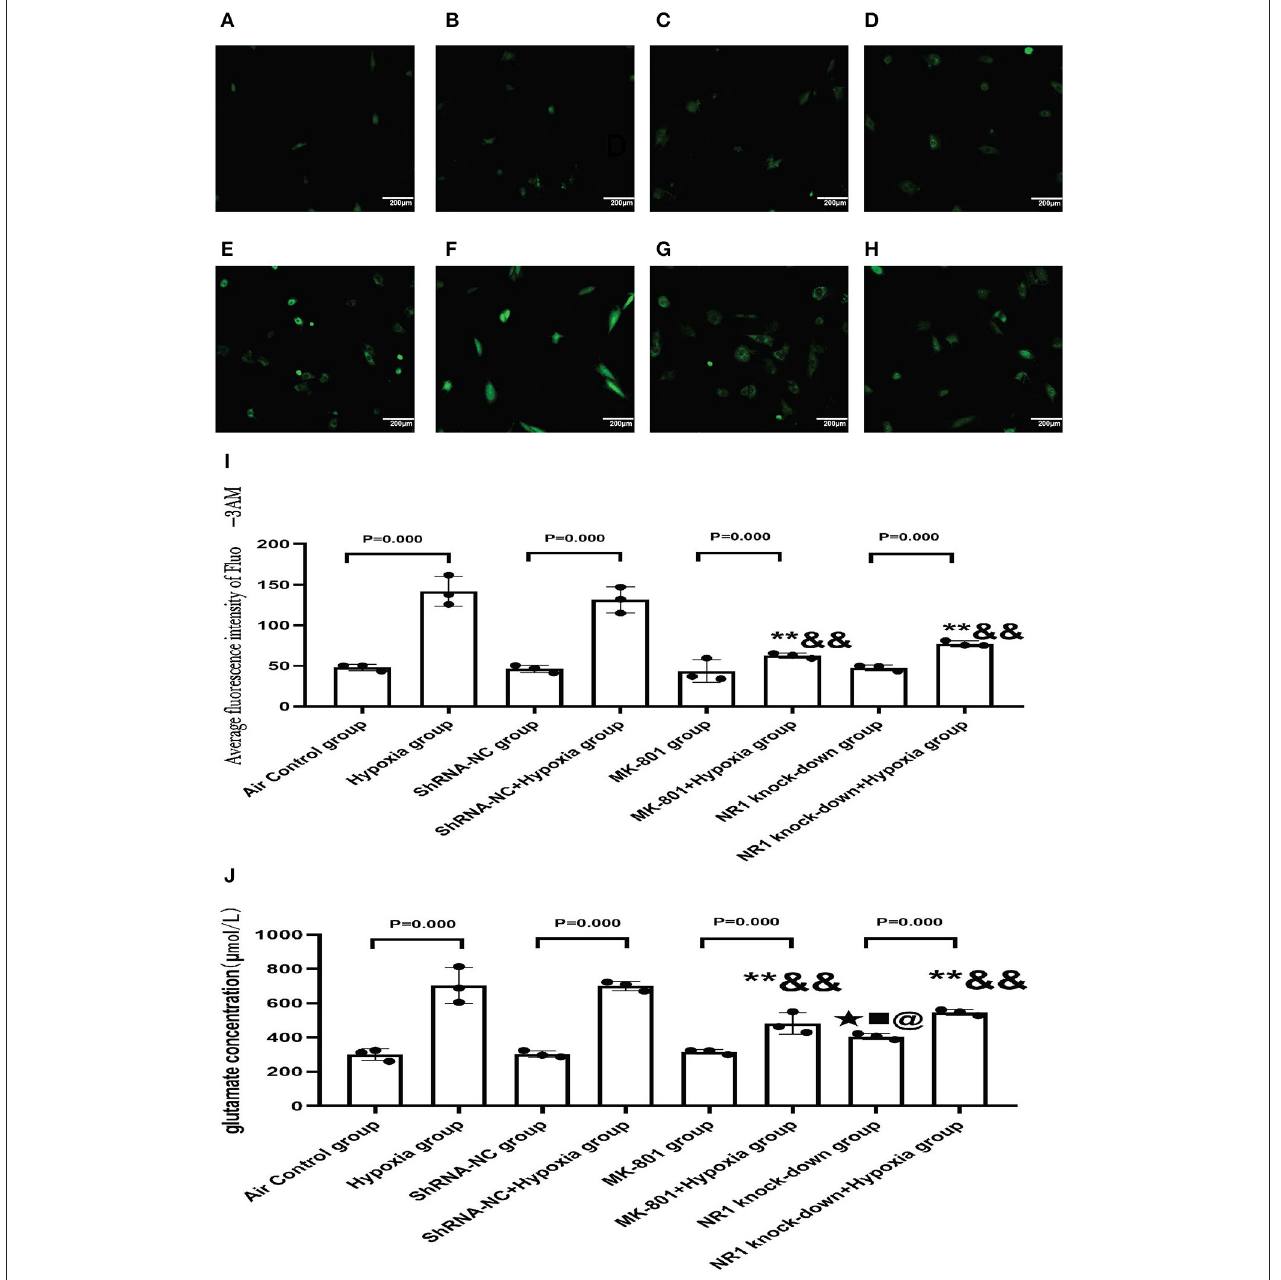
FIGURE 9 | (A–H) The representative florescence images of Ca2 + (200x). (A–D) Air control group (A) , shRNA-NC group (B) , MK-801 group (C) , and NR1 knock-down group (D) ; (E–H) : Hypoxia group (E) , shRNA-NC + hypoxia group (F) , MK801 + hypoxia group (G) , and NR1 knock-down+hypoxia group (H) ; (I) : The average intensity of Ca2 + fluorescence; (J) : The glutamate concentration in different groups. Compared with the Hyppoxia group: * P < 0.05, ** P < 0.01; compared with the shRNA-NC+hypoxia group: & P < 0.05, && P < 0.01; compared with the air control group, N P < 0.05, NN P < 0.01; compared with the ShRNA-NC group, (cid:4) P < 0.05, (cid:4)(cid:4) P < 0.01;comparead with the MK-801 group, @ P < 0.05, @@ P < 0.01. All data are presented as mean ± S.E.M. N =